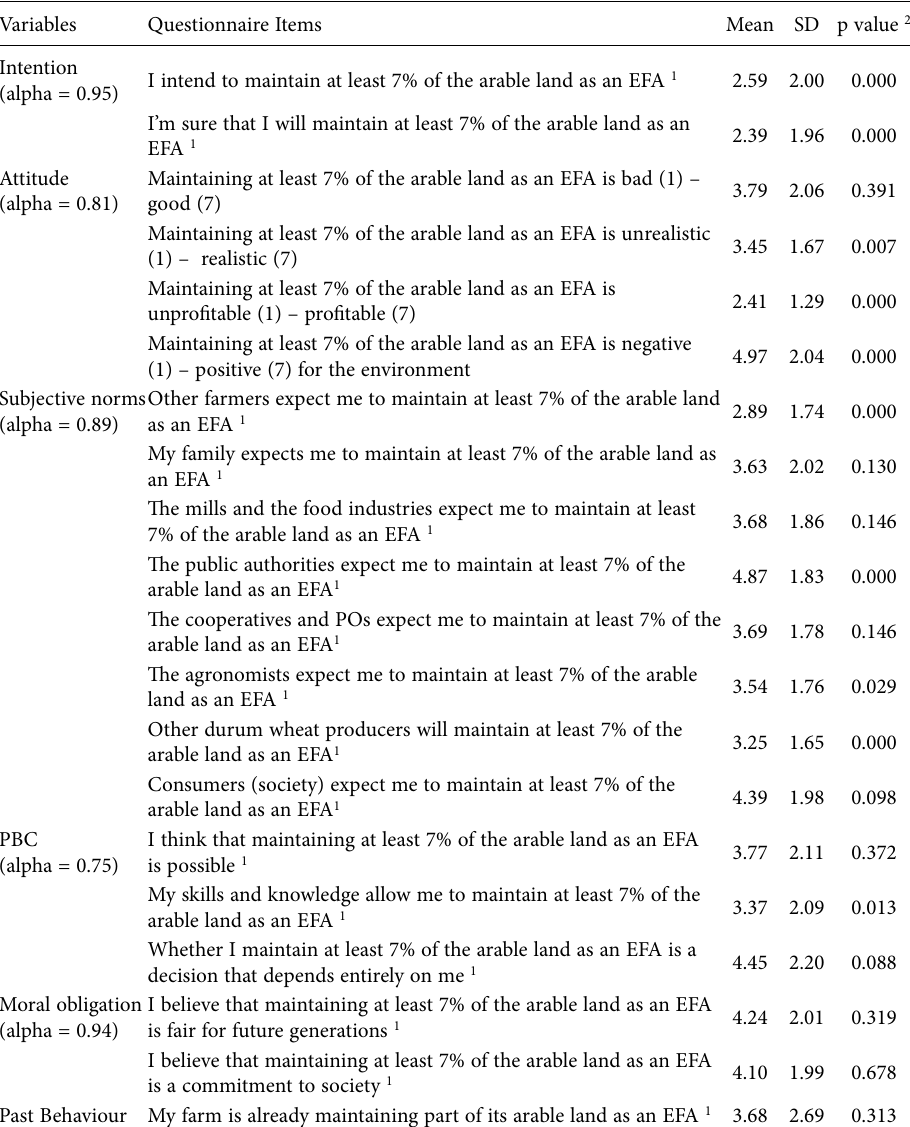
Table 3. Variables and questionnaire items of behaviour 1 “Ecological focus area”, Cronbach’s alpha, means and standard deviations